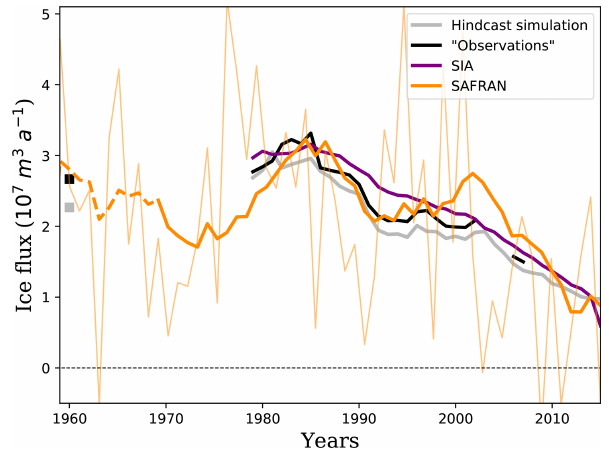
Figure 3. Ice flux through the Tacul gate from 1979 to 2015 based on a previous estimate (Berthier and Vincent, 2012; in black), from the shallow ice approximation (SIA) using only observed ice thick- nesses at the Tacul gate (purple), as imposed for the hindcast simula- tions (gray; see text) and compared to the yearly SAFRAN surface mass balance integrated upstream of the Tacul gate (thin orange) and its 11-year running mean (thick